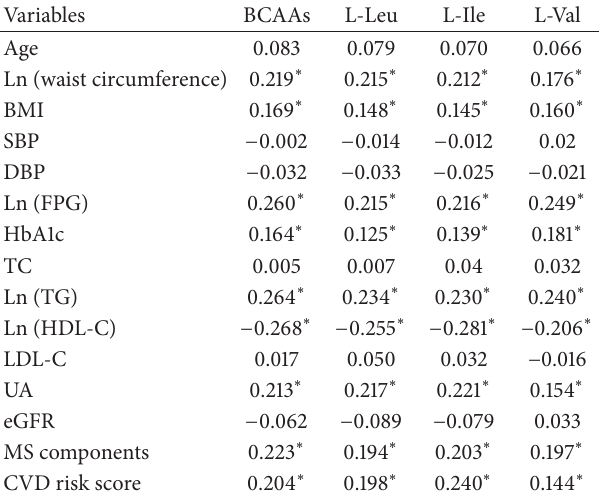
Table 2: Correlations between BCAAs and cardiometabolic risk